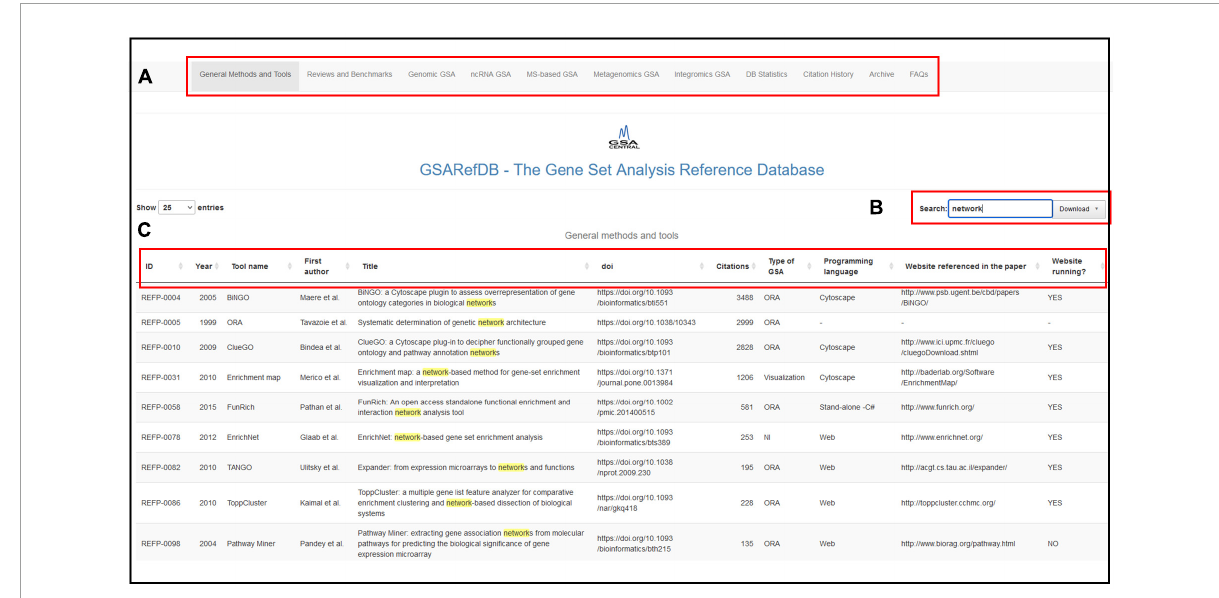
FIGURE4 GSARefDB screenshot. (A) Main Menu: The user can choose between the database of general methods and tools, the database of reviews and benchmarks, the specialized databases (genomic GSA, nc-RNA GSA, MS-based GSA, meta-omics GSA, and integromics GSA), general GSARefDB statistics, the archive, and FAQs. (B) The search box: Here, we search for papers with the keyword “network”. (C) The columns with all the information we can obtain from each paper: ID, publication year, tool name, first author, paper title, DOI, number of citations, type of GSA, programming language, and website info.